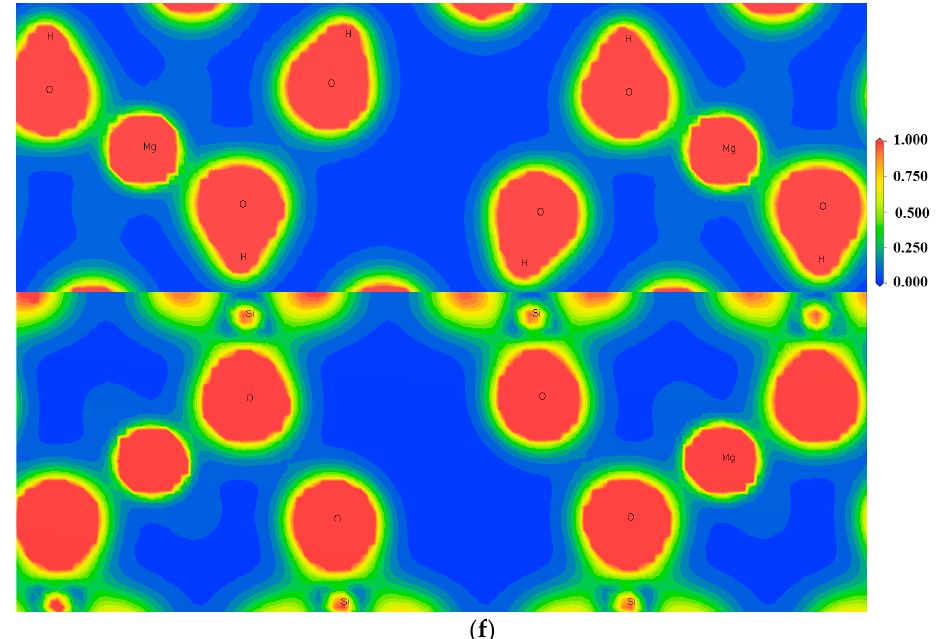
Figure 5. Charge density diagram of talc point defect surface: ( a ) Fe impurity defect surface, ( b ) Mn impurity defect surface, ( c ) Ni impurity defect surface, ( d ) Al impurity defect surface, ( e ) Ca impurity defect surface, and ( f ) Mg vacancy surface.